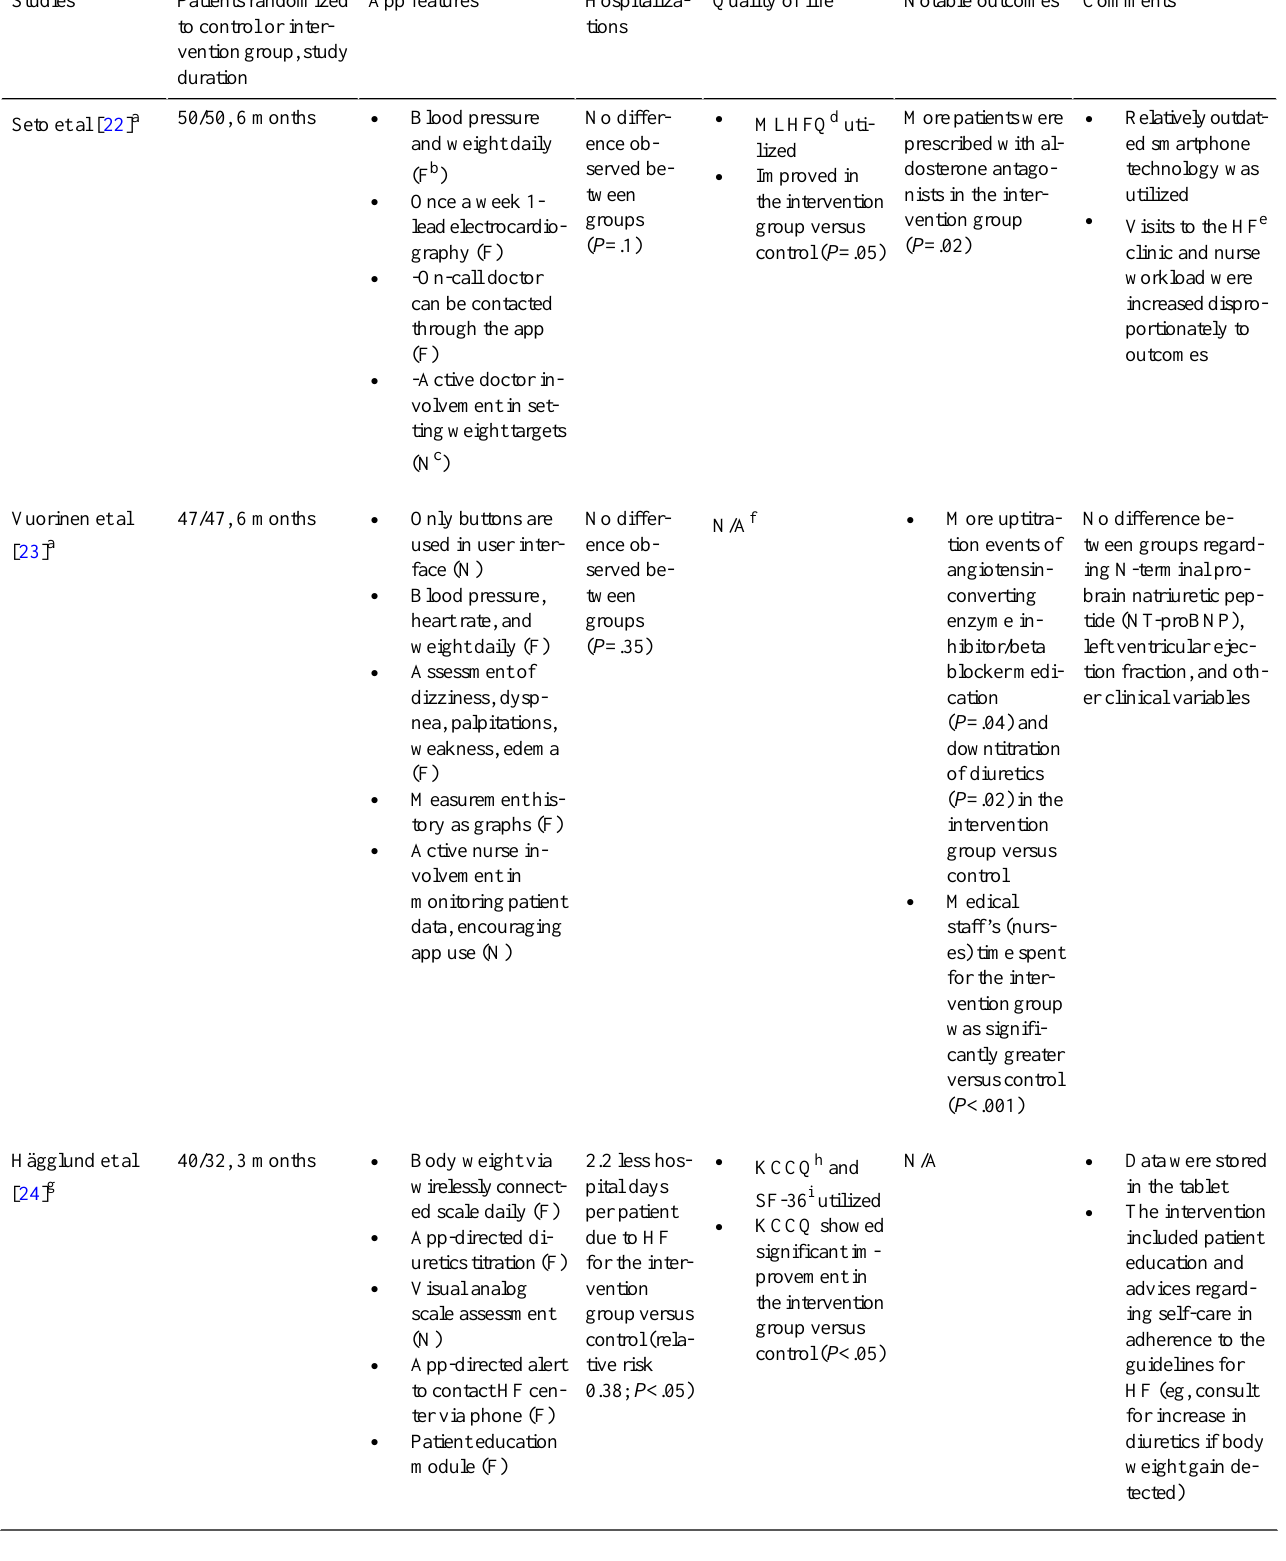
Table 1. An overview of the 4 randomized controlled trials included in the systematic